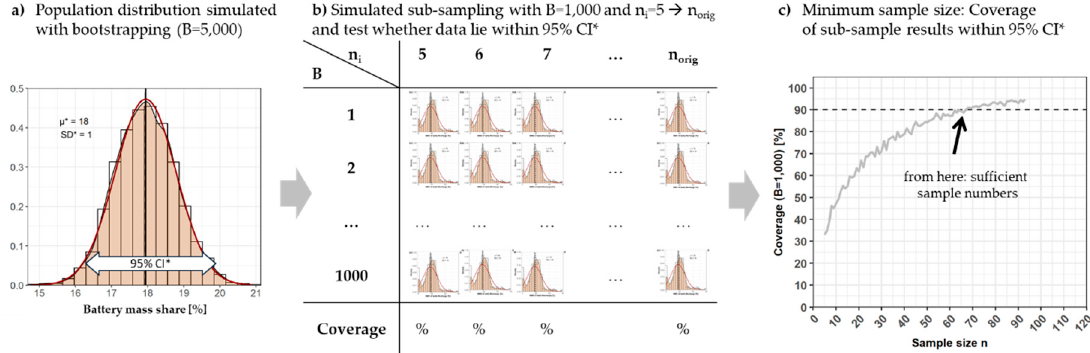
Figure 1. Non-parametric approach (NPA) to approximate the minimum sample sizes (MSS) with data-driven simulations. ( a ) Simulated bootstrap population, ( b ) sub-sampling from datasets with increasing sample size and 1000 repetitions, ( c ) coverage of sub-sample results in percent lying within the population 95% confidence interval (CI*).